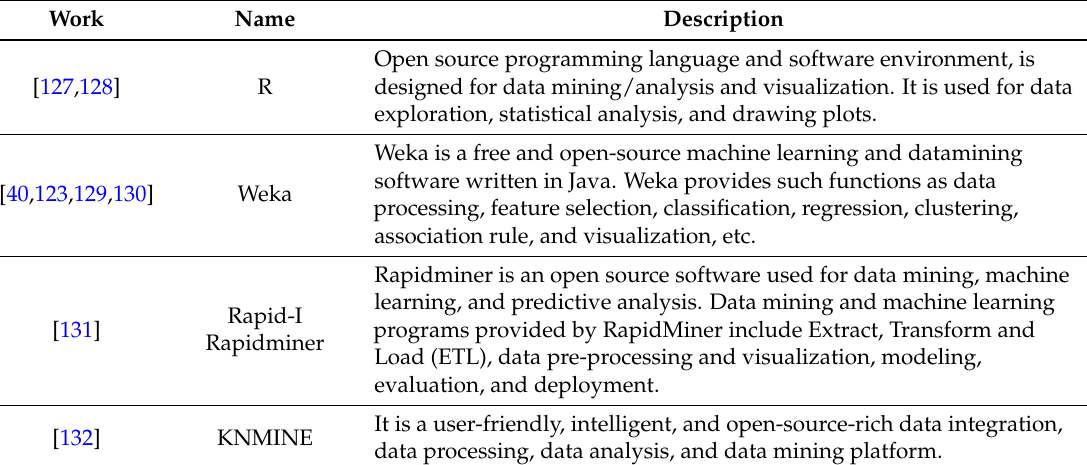
Table 6. Data Mining for